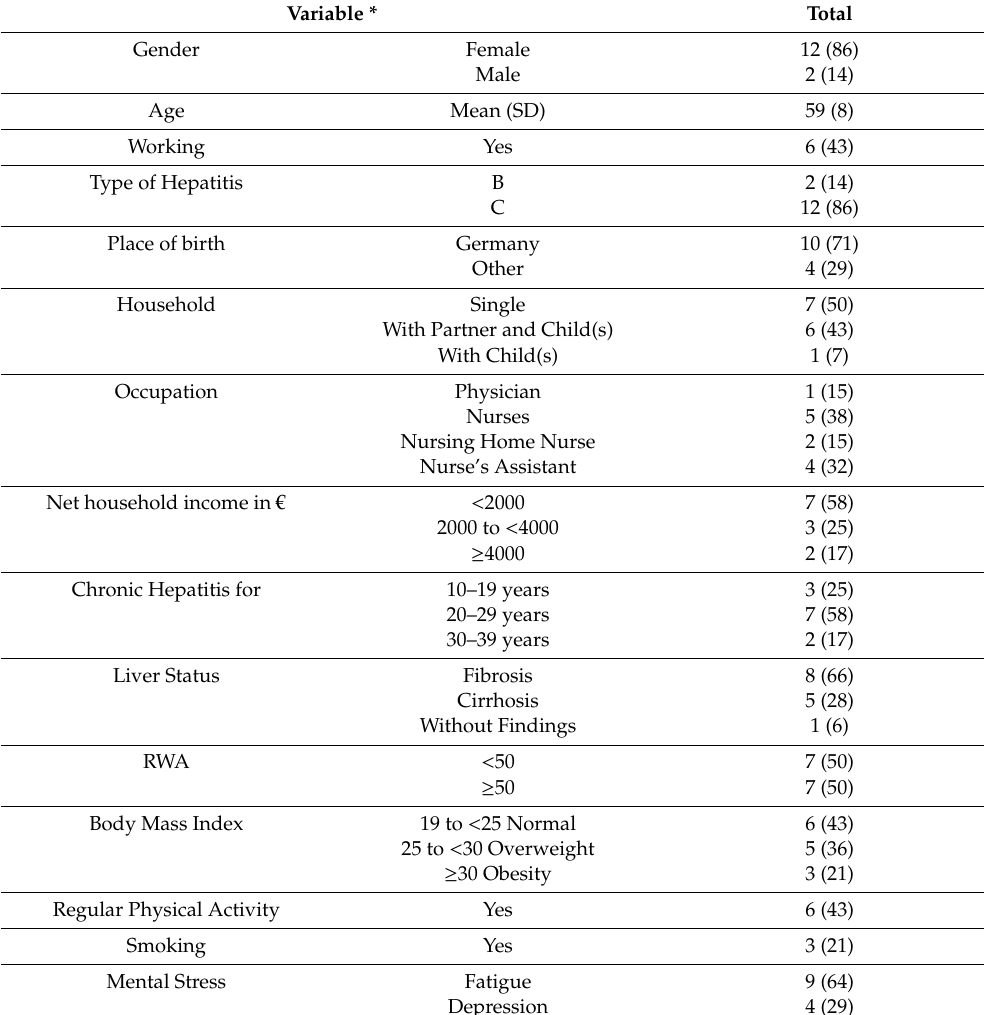
Table A1. Drop-out details ( n =